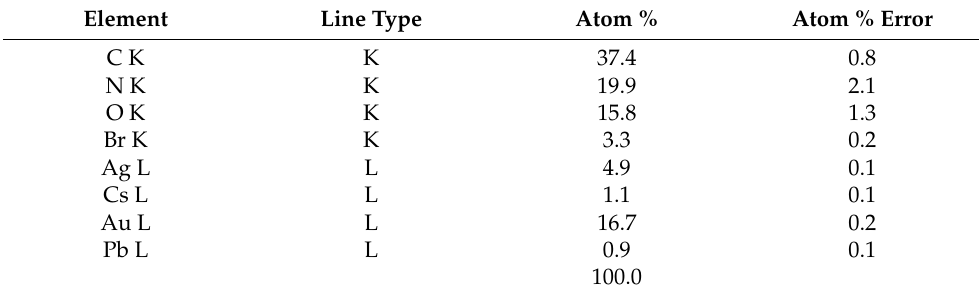
Table 2. SEM–EDX measurements on CsPbBr 3 NCs@NP Au sample. Element Table 2 . SEM–EDX measurements on CsPbBr 3 NCs@NP Au sample.